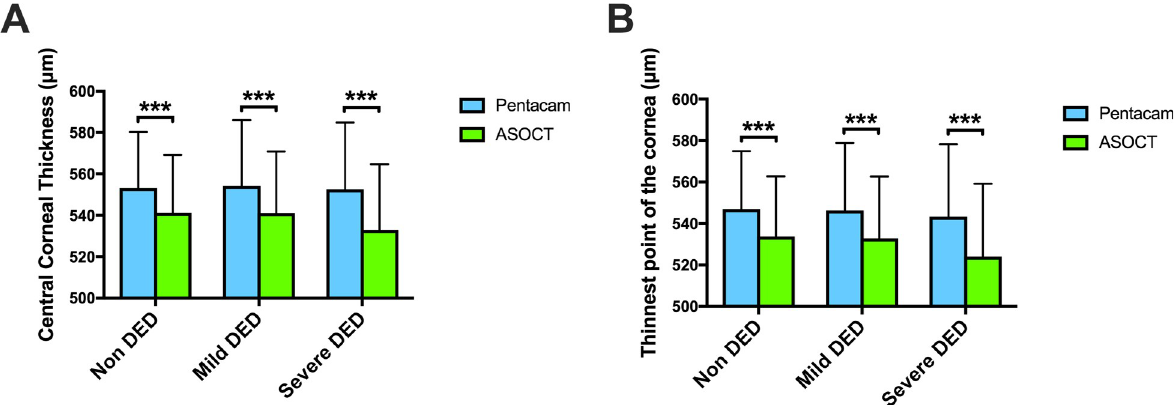
Fig 1. Comparison of corneal thickness assessment between Pentacam and ASOCT in patients with Dry Eye Disease. ( A ) The central corneal thickness and ( B ) the thinnest points of the cornea were compared between Pentacam and ASOCT according to the subgroups. Data are considered statistically significant at ��� P < 0.001. DED: dry eye disease, ASOCT: anterior segment optical coherence tomography.